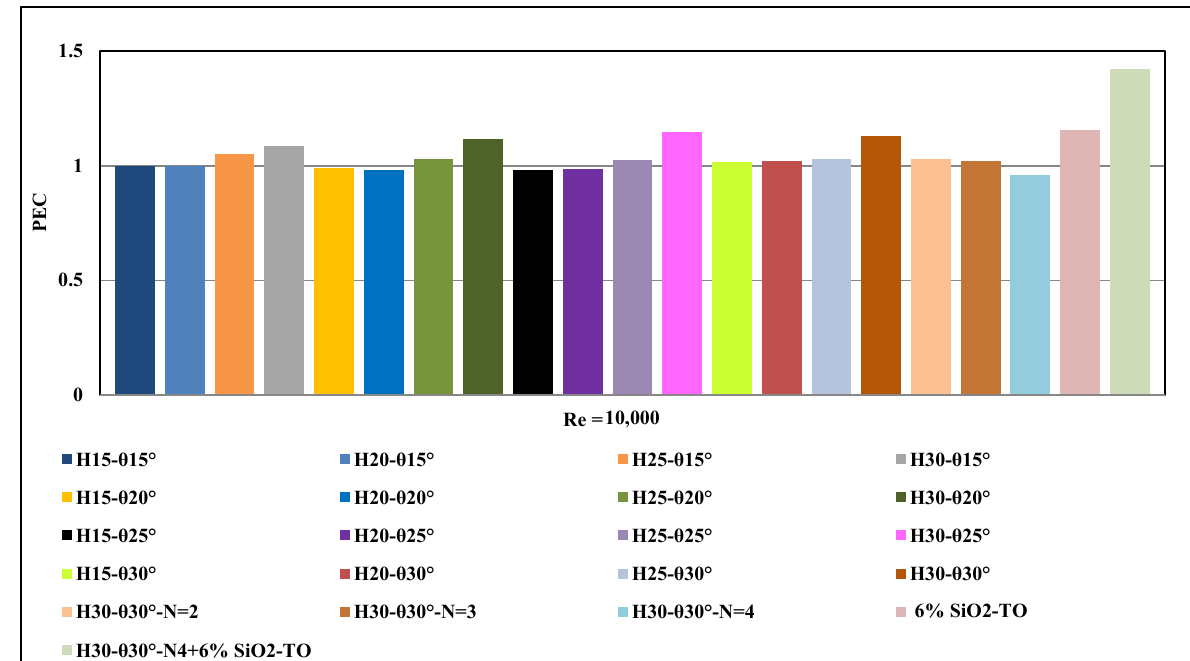
). Figure 16. Effect of configuration changes on the performance evaluation criterion ( PEC 𝑃𝑃𝑃𝑃𝐶𝐶